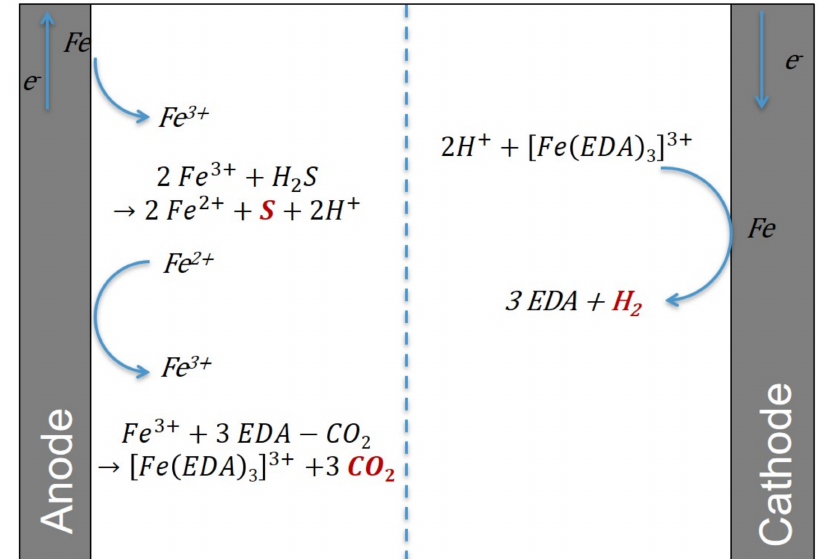
Figure 3. A detailed diagram of the chemical reactions taking place in the electrochemical